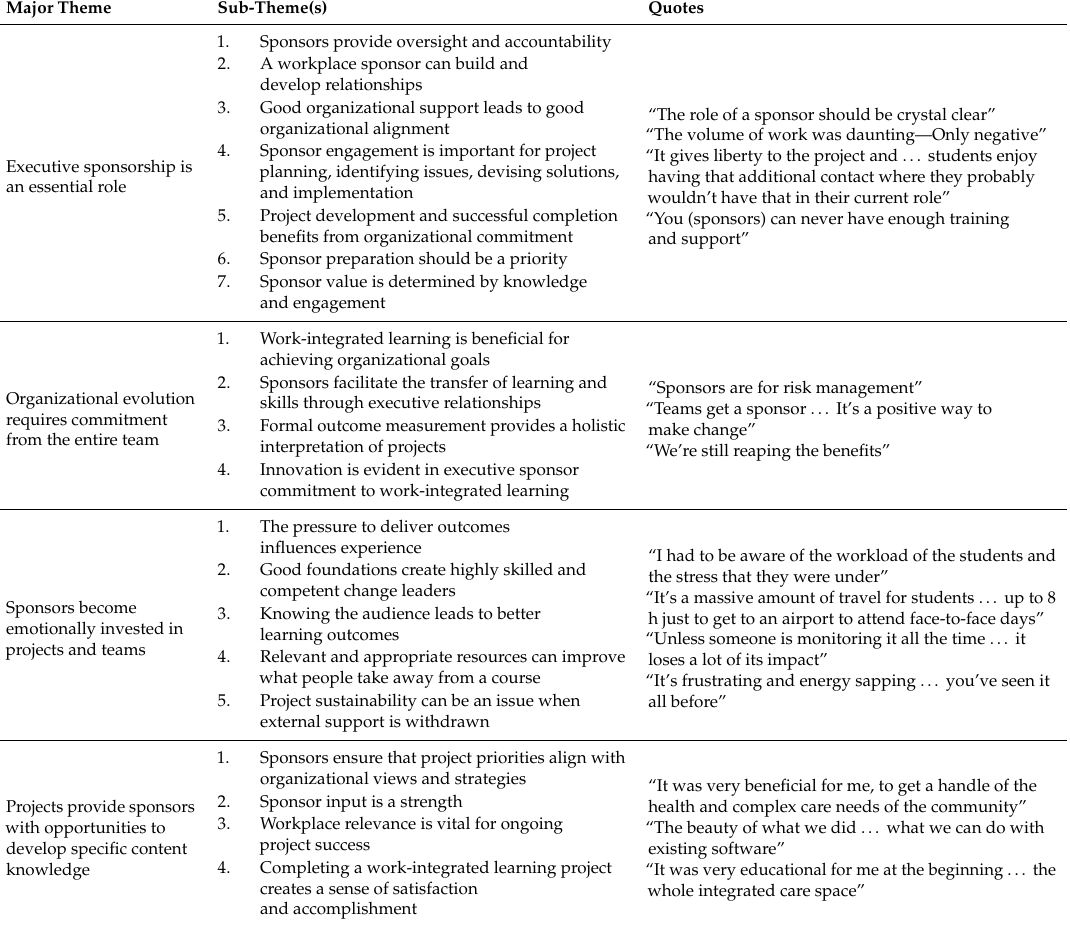
Table 7. Themes from executive sponsor